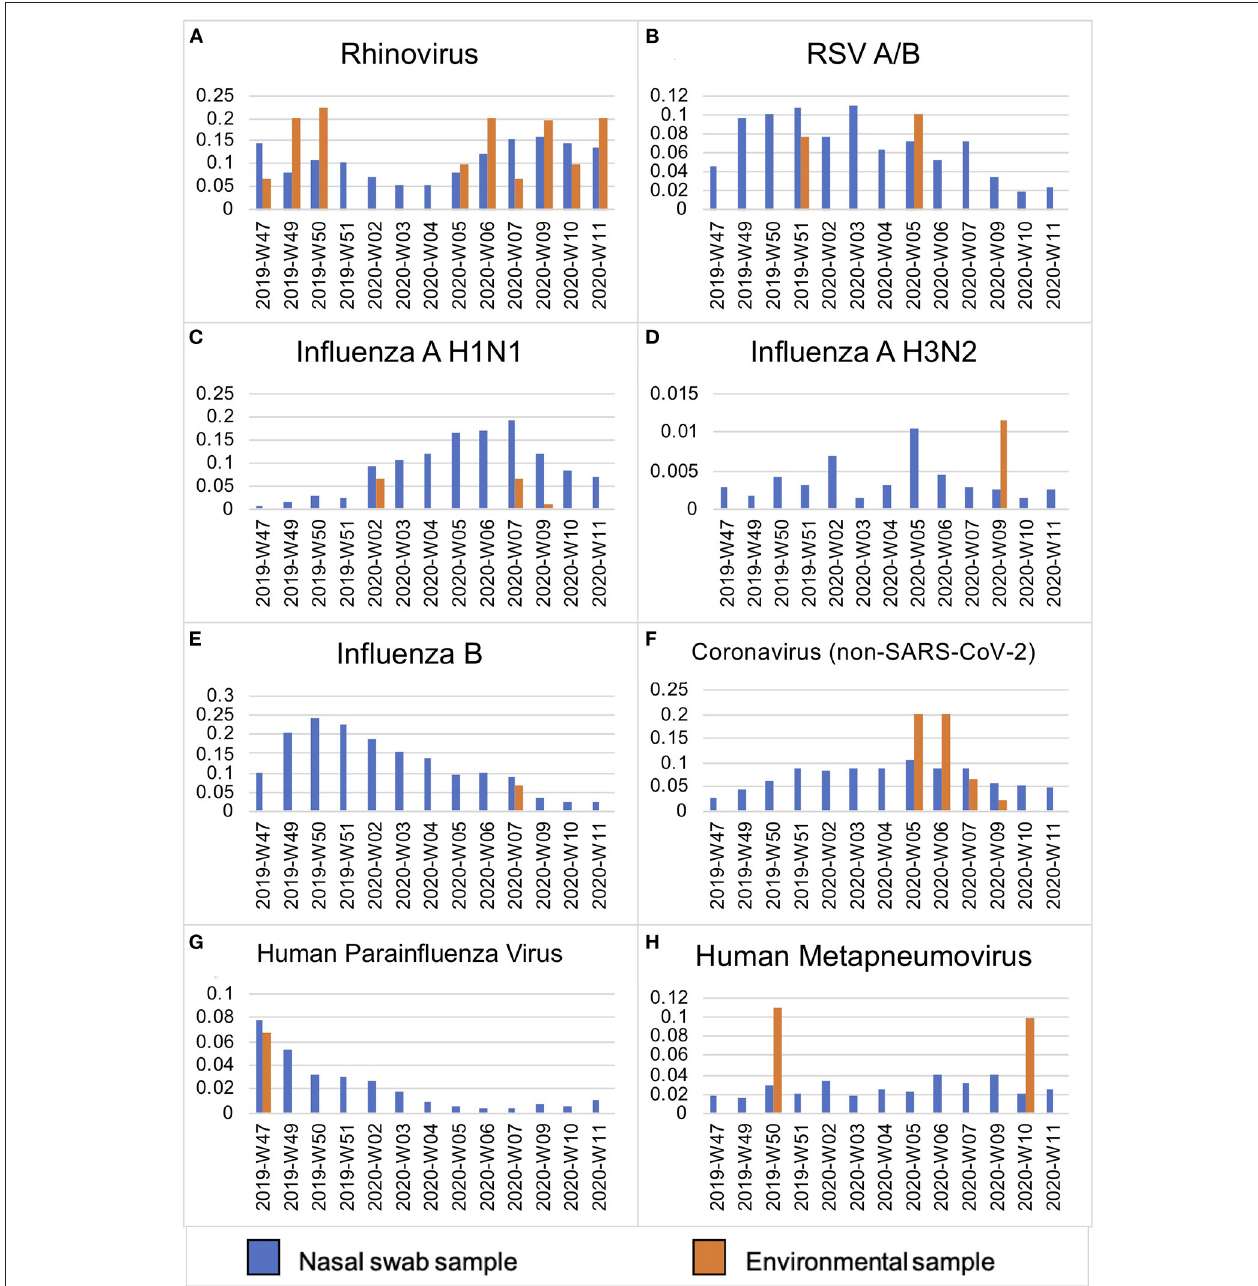
FIGURE 1 | Viral prevalence by week in Seattle, WA from November 2019–March 2020 in symptomatic individuals as compared to environmental surface swabs in schools. Prevalence (y-axis) of viral pathogens (A–H) detected in de-identified residual samples from hospitalized patients and prospective mid-turbinate swabs from symptomatic individuals in Seattle, WA, USA ( n = 12,458) as compared to contemporaneous environmental surface swab sampling in Seattle public schools ( n = 208) between November 2019–March 2020 (by week,